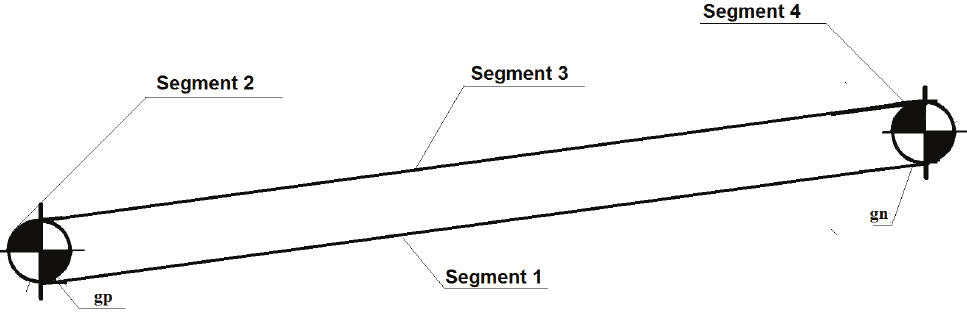
Fig. 3. Discretized model of a scraper